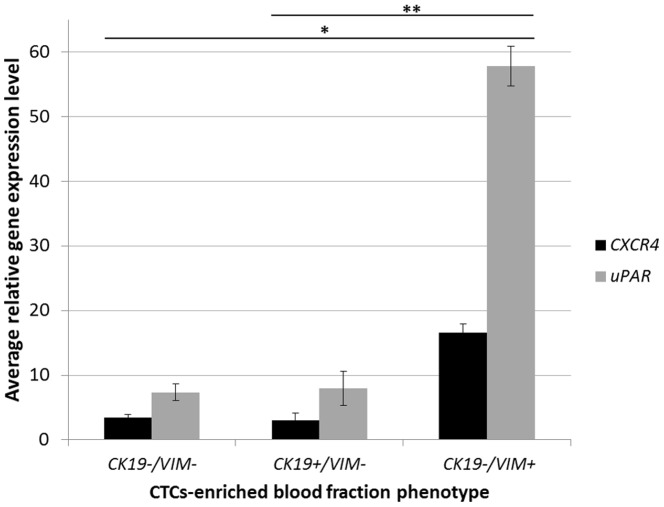
Relative expression level of CXCR4 and uPAR in CTC-enriched blood fractions.CTC-enriched blood fractions positive for either MGB1 or HER2 were divided according to VIM and CK19 expression status into three groups (CK19−/VIM−; CK19+/VIM−; CK19−/VIM+). Error bars depict standard error. * - statistically significant difference in CXCR4 and uPAR relative expression level (P<0.00001 for both) between CK19−/VIM− and CK19−/VIM+; ** - statistically significant difference in CXCR4 (P = 0.00002) and uPAR (P = 0.00004) relative expression level between CK19+/VIM− and CK19−/VIM+.